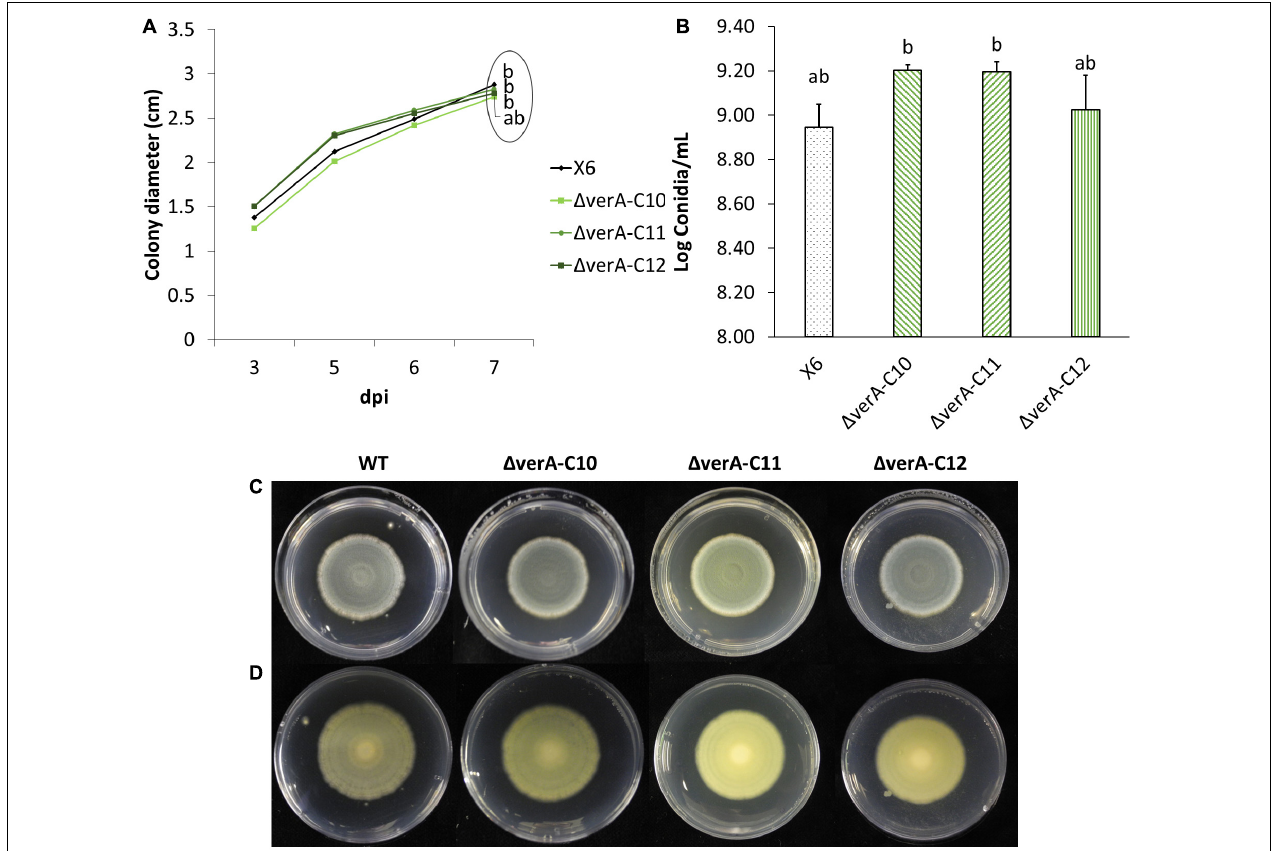
FIGURE 4 | Effect of verA deletion on P. polonicum growth in vitro. Colony diameter after 3 to 7 days post inoculation (A) conidia production (B) and plate view (front C and reverse D ) at 7 days post inoculation (dpi) on PDA. WT, wild-type P. polonicum X6; (cid:49) verA, deletion mutants for verA ( cl4A ). Values followed by the same letter are not statistically different by Tukey’s b multiple comparison test ( p <